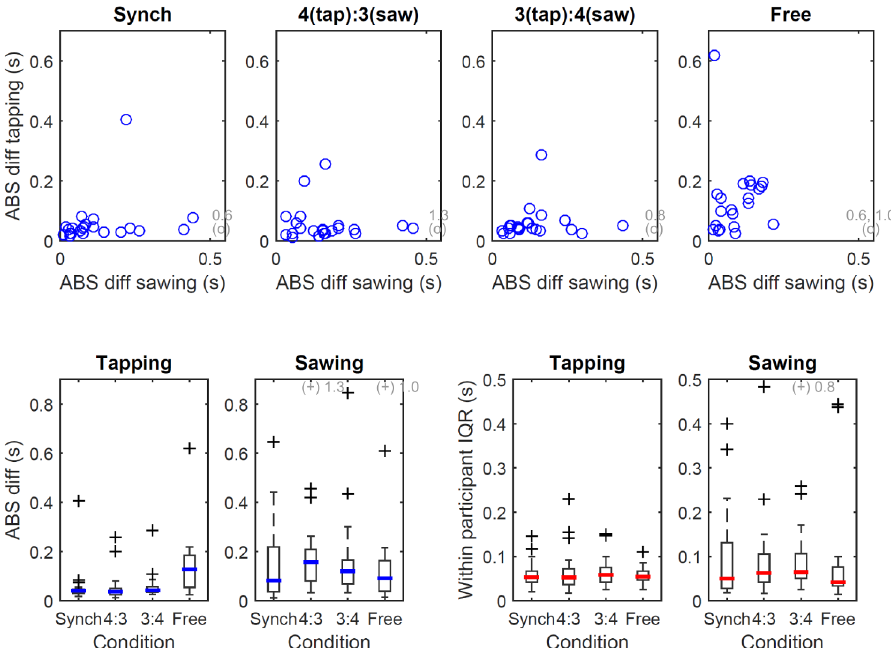
Fig 5. Top: relationshipof the medianabsolute difference betweenobservedand expectedcycle durationfor the handengagingin sawingcomparedto the hand engagingin tapping.Most of the deviationfrom the expectedratio is due to the difference between expected and observed sawingcycle duration. Bottom: medianabsolute difference betweenobservedand expectedcycle duration(left) and within-participant variation thereof (right) for sawingand tapping. Complementary to the data presented in Fig 3, the deviation from the expectedcycle durationis larger for sawing, howeverthe within-participant variation in the deviation is similar for sawingand